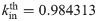
Nullclines of the CCC model.Red and green lines represent the nullclines for [m0] and [m1], respectively. Gray arrows are vector fields. kin is (A) 0.8, (B) kinth=0.984313, and (C) 1.2. When kin is smaller than kinth, a stable fixed point exists, whereas there is no stable fixed point and [m0] will diverge when kin is larger than kinth.